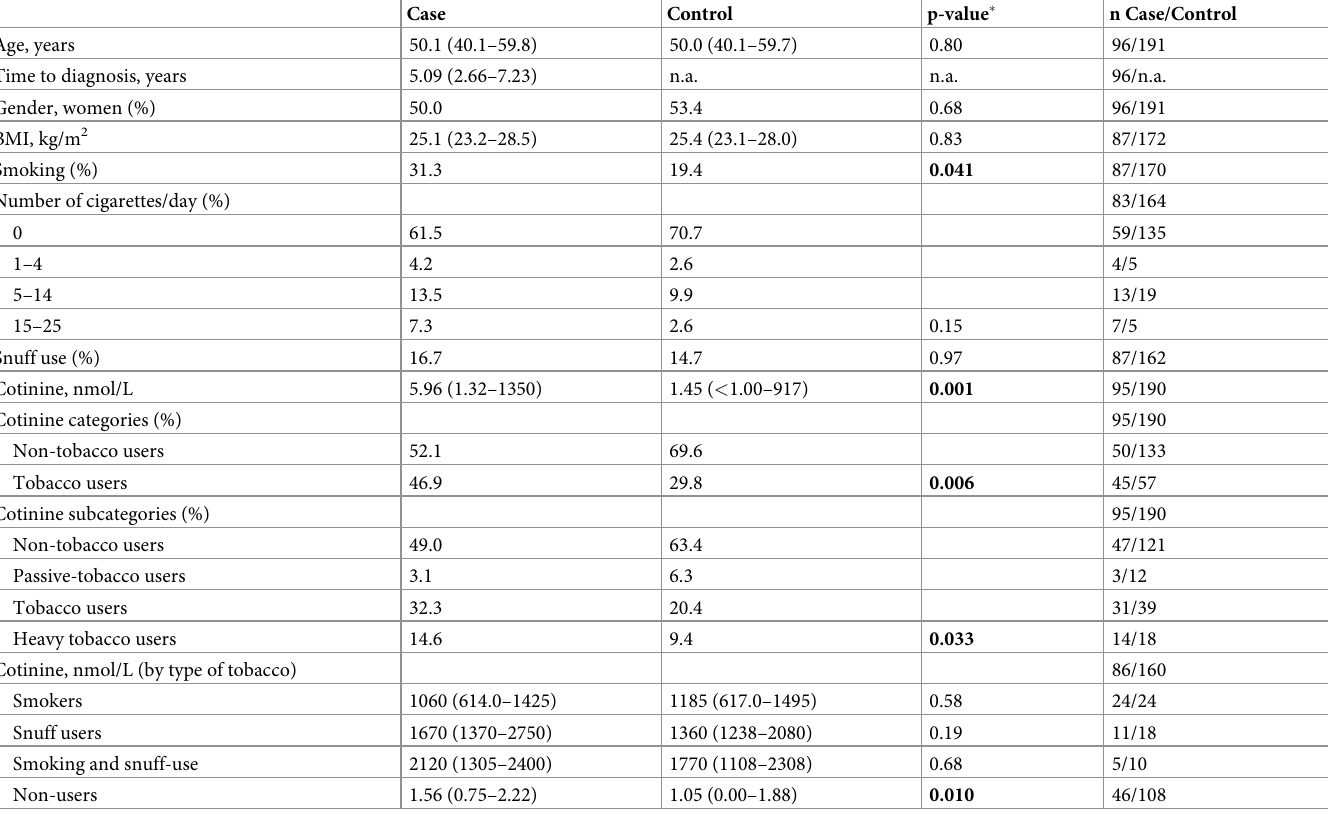
Table 1. Baseline characteristics for subjects who later developed IBD (case) and controls.